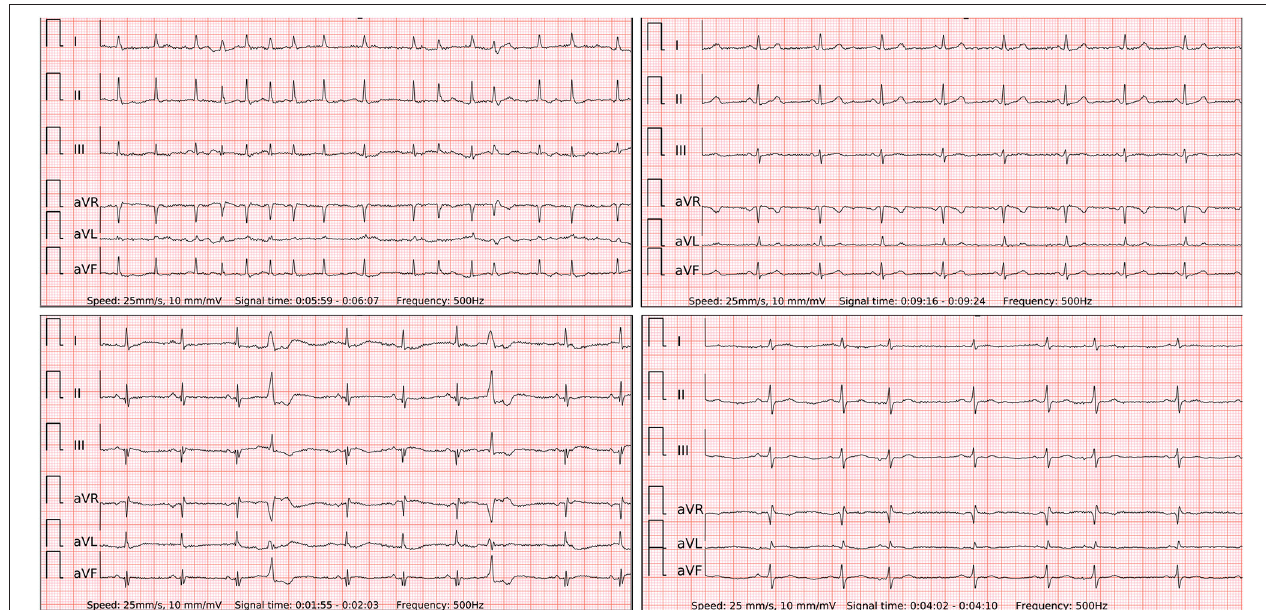
FIGURE 3 | Flow chart of patients. AF, atrial fibrillation; SR, sinus rhythm; PVC, premature ventricular contraction; PAC, premature atrial contraction; ECG, electrocardiography; PPG, photoplethysmography.